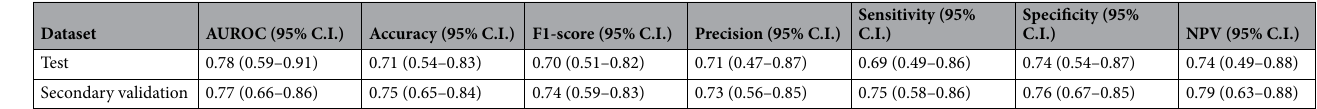
Table 2. Performance of semi-supervised classifier on test data. AUROC area under the receiver operating curve, C.I confidence interval, NPV negative predictive value.